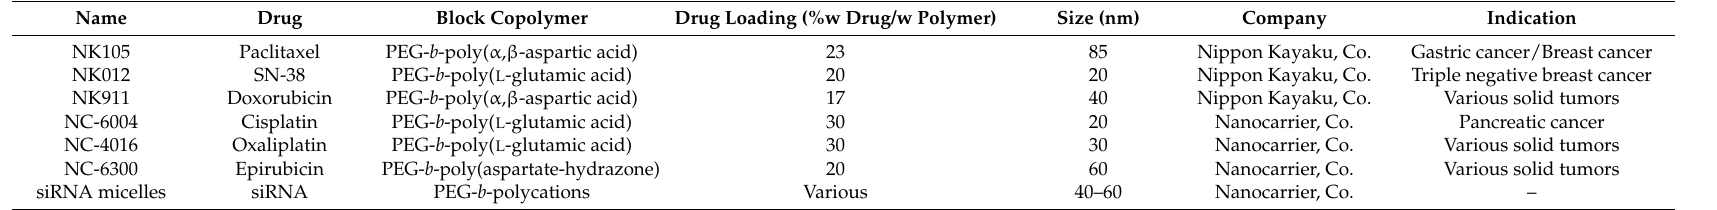
Table 2. Micelles as carriers for cancer therapies (reproduced from ref [81]) with permission, (Copyright Elsevier